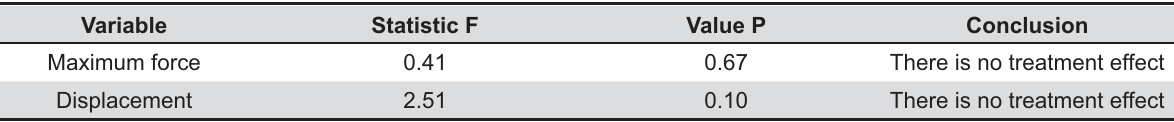
Table 2- Values of the statistics F and P, resulting from the application of ANOVA for statistical analysis of the variables: maximum force and